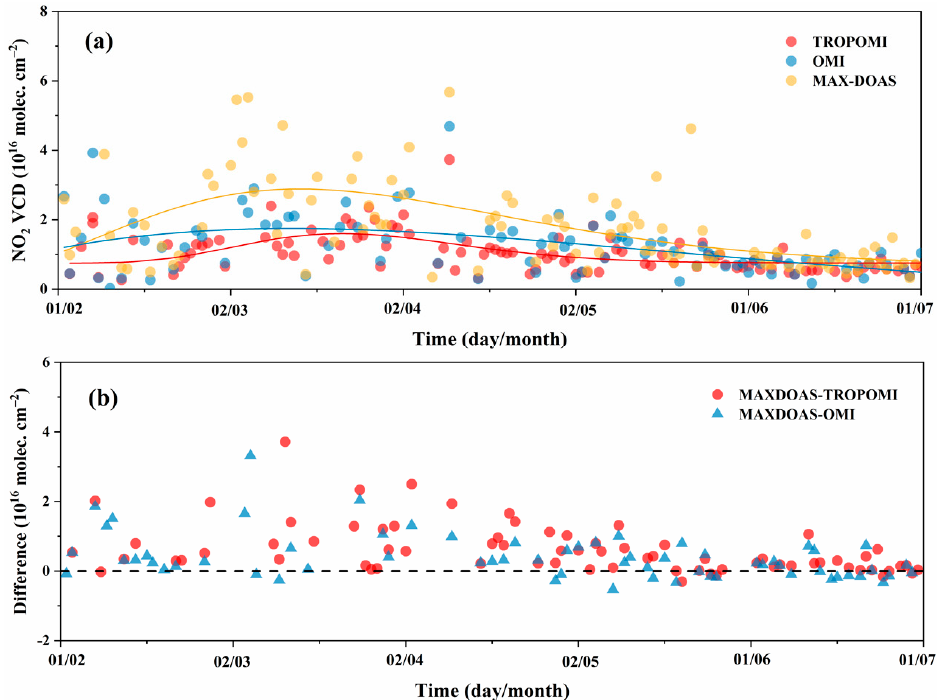
Figure 9. ( a ) Time series of tropospheric NO 2 VCDs from February to June in 2018. Solid lines represent the fit curves of the three datasets. ( b ) Daily mean absolute differences between MAX ‐ DOAS and satellite tropospheric NO 2 VCDs. Blue triangles indicate MAX ‐ DOAS minus OMI data, and red dots represent MAX ‐ DOAS minus TROPOMI75 (unit: 10 16 molec cm –2 ).